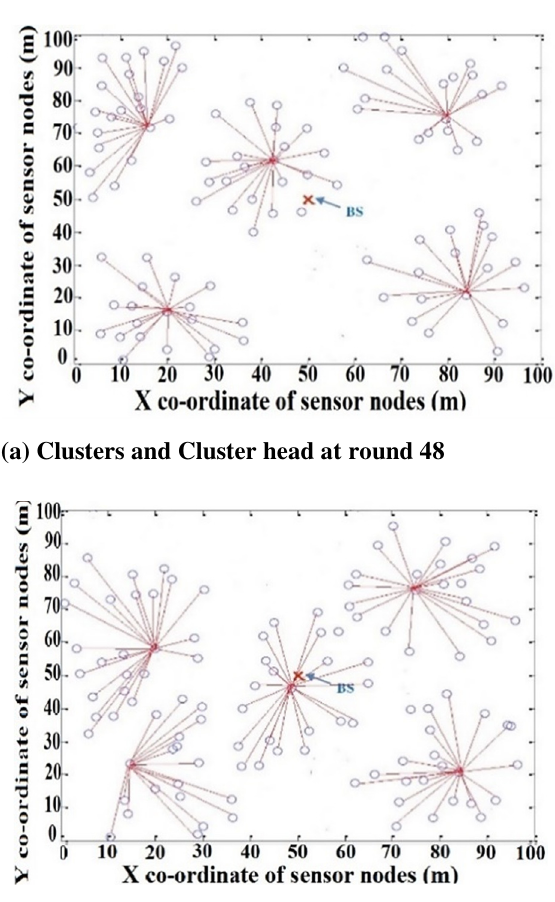
Fig. 10. Movement of doctors within the city of